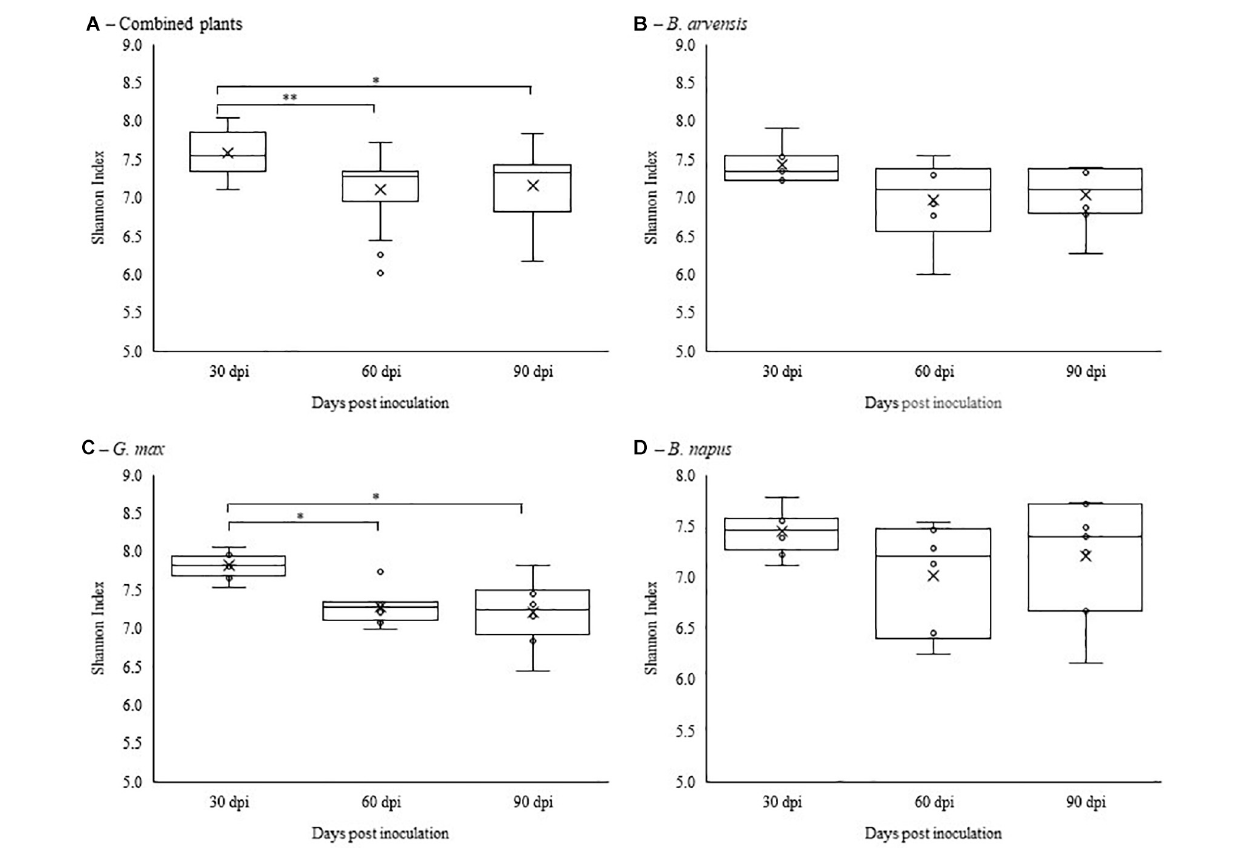
FIGURE 2 | Temporal variations of alpha-diversity metrics in the bacterial microbiome of three oil-producing crops. (A) Alpha-diversity metric (Shannon’s index) of temporal variations for all plants and treatments combined. (B) Alpha-diversity metric (Shannon’s index) of temporal variations for B. arvensis plants and treatments combined. (C) Alpha-diversity metric (Shannon’s index) of temporal variations for G. max plants and treatments combined. (D) Alpha-diversity metric (Shannon’s index) of temporal variations for B. napus plants and treatments combined. Kruskal-Wallis pair-wise test was used to assess statistical significance between groups (** p < 0.001, * p <